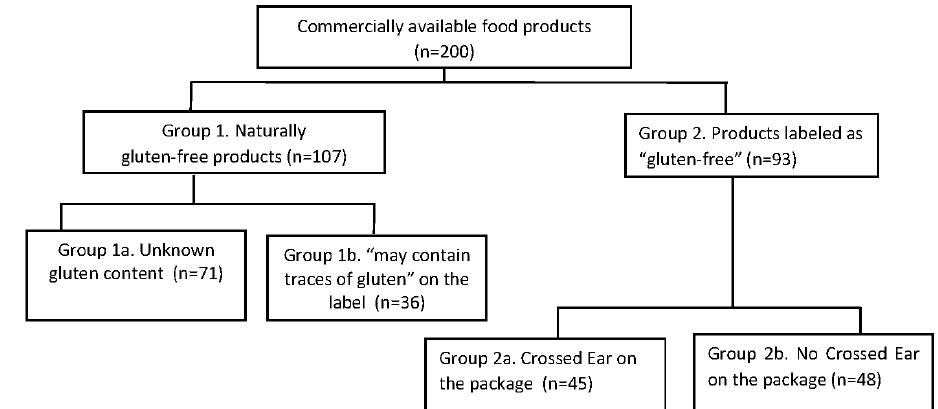
Figure 1. Types of food products analyzed in this study.